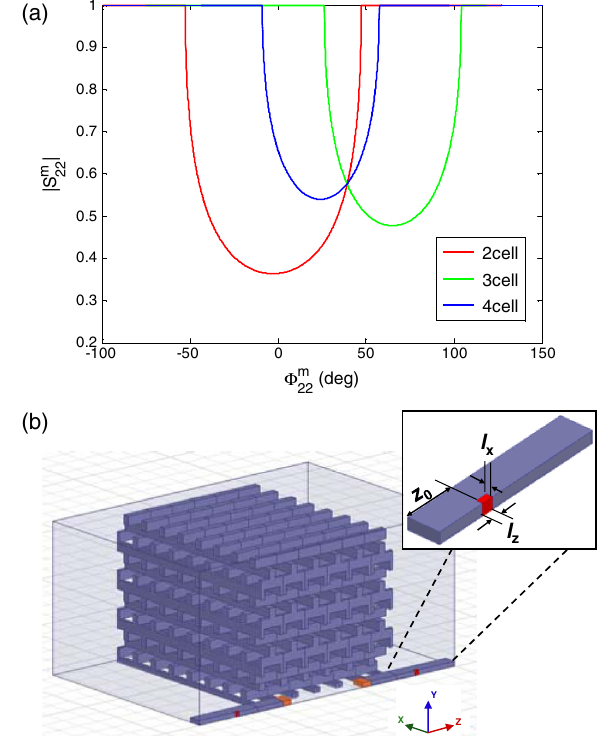
FIG. 4. (a) Multiple-cell simulation to determine the required S 22 m for a traveling-wave match to a TE-mode woodpile wave- guide. (b) The traveling-wave mode launcher design: perturbation in a silicon guide by a piece of perfect conductor, with its dimensions marked in the